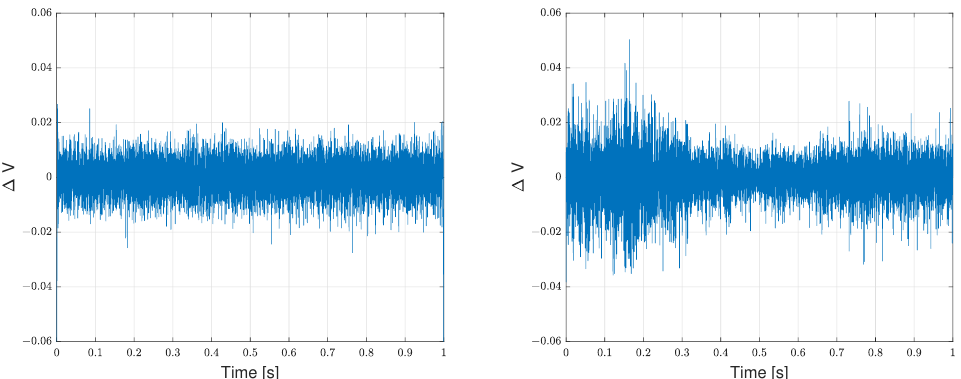
Figure 6. Left microphone data segments from the wind tunnel experimental run at a flow velocity of 12 m/s, AoA of 0 ◦ and UAV motor configuration R ( left plot) and flight data from a phase of steady forward flight at an average airspeed of 12 m/s ( right plot).